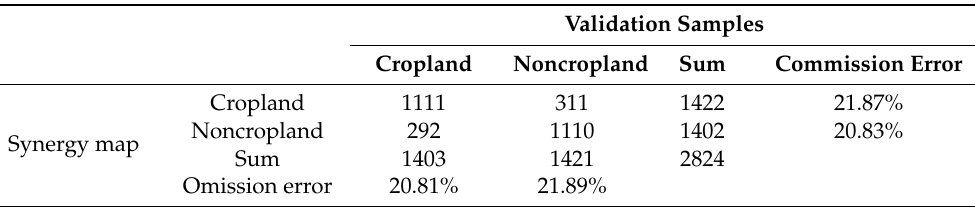
Table 4. Validation results of the synergy map.